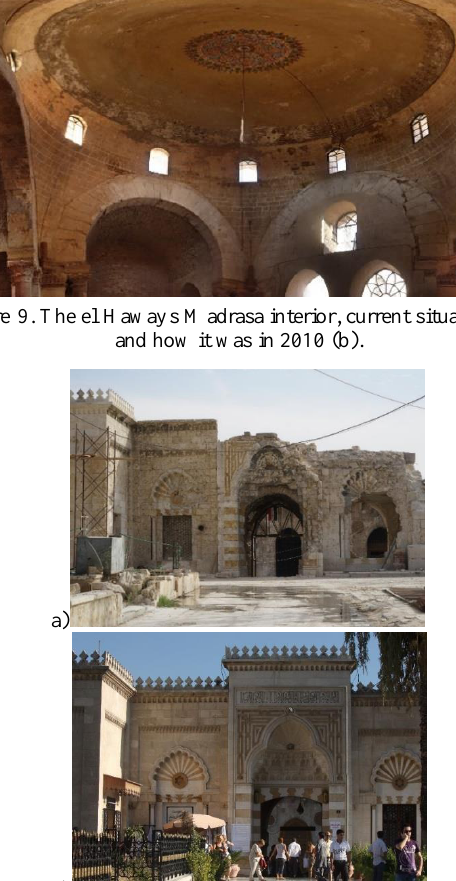
Figure 10. The entrance gate to the Great Mosque, current situation (a) and how it was in 2010 (b).